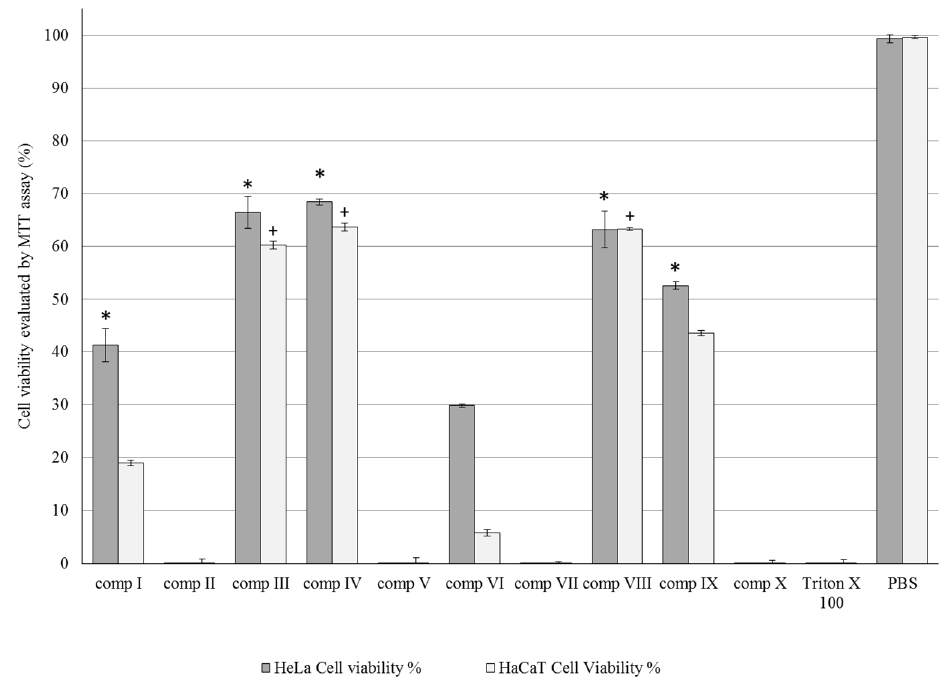
Figure 3. Cell viability evaluation following MTT assay on HaCaT and HeLa cells treated with compositions I–X Each data point represents the mean ± S.D., n = 10. Repeated-Measures ANOVA and Pearson correlation tests were performed. Significant differences ( p > 0.05) are marked with * and crosses in our designed figures. * and + show the significance levels in the case of compositions I–X compared to the positive (Triton-X) and negative (PBS) controls.